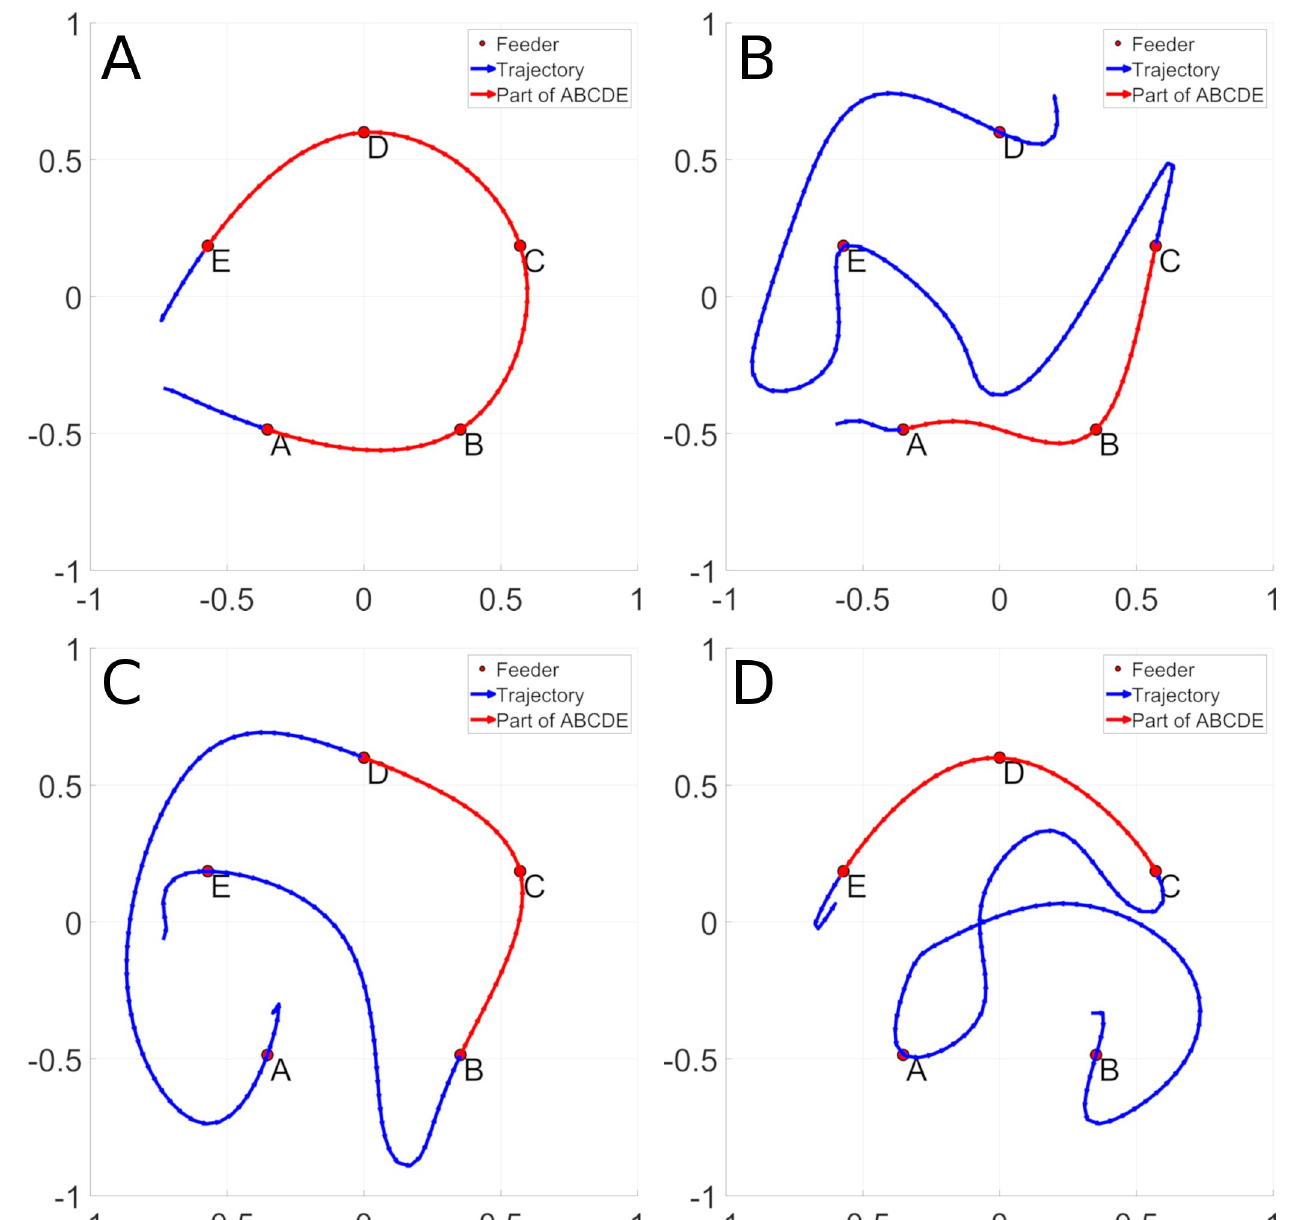
Fig 1. An optimal trajectory between feeders ABCDE is represented in panel A. Panel B, C and D display non optimal trajectories that contain a sub trajectory of the ABCDE trajectory. The sub trajectory shared with the ABCDE trajectory is displayed in red and the non-optimal parts in blue. Panel B contains the ABCED, panel C the EBCDA trajectory and panel D the BACDE